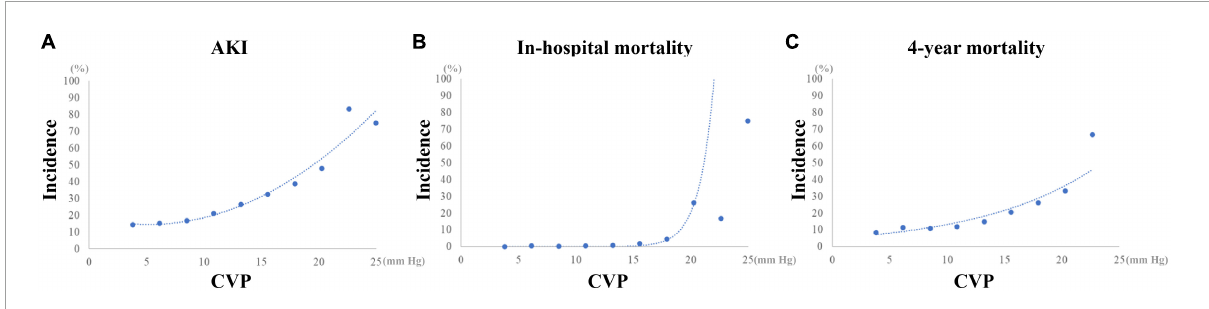
FIGURE5 Curvilinear relationship between CVP and the outcomes of CABG patients. (A) Incidence of AKI. (B) Incidence of in-hospital mortality. (C) Incidence of 4-year mortality. AKI, Acute kidney injury; CABG, Coronary artery bypass grafting; CVP, Central venous pressure.